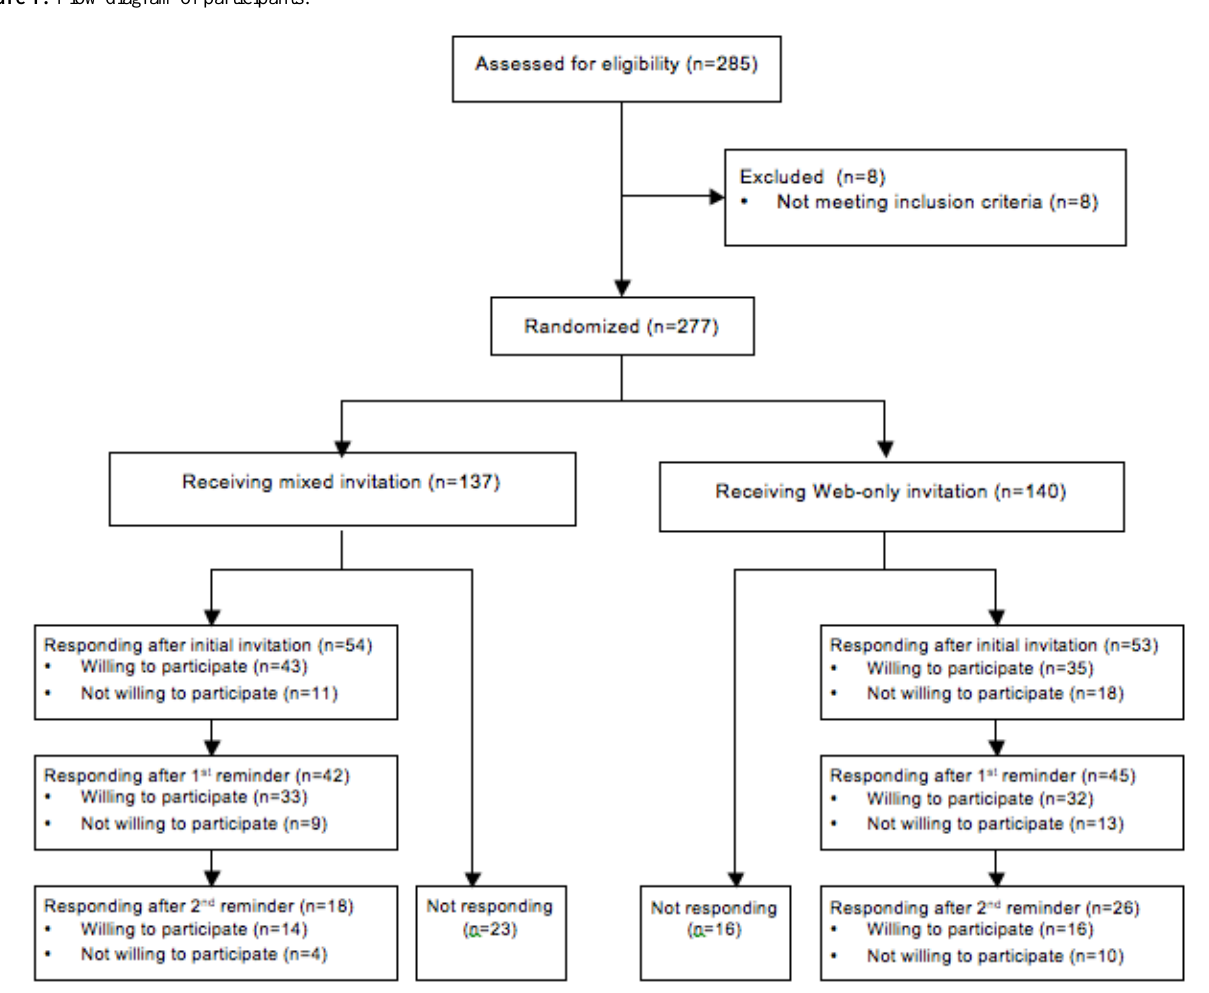
Figure 1. Flow diagram of